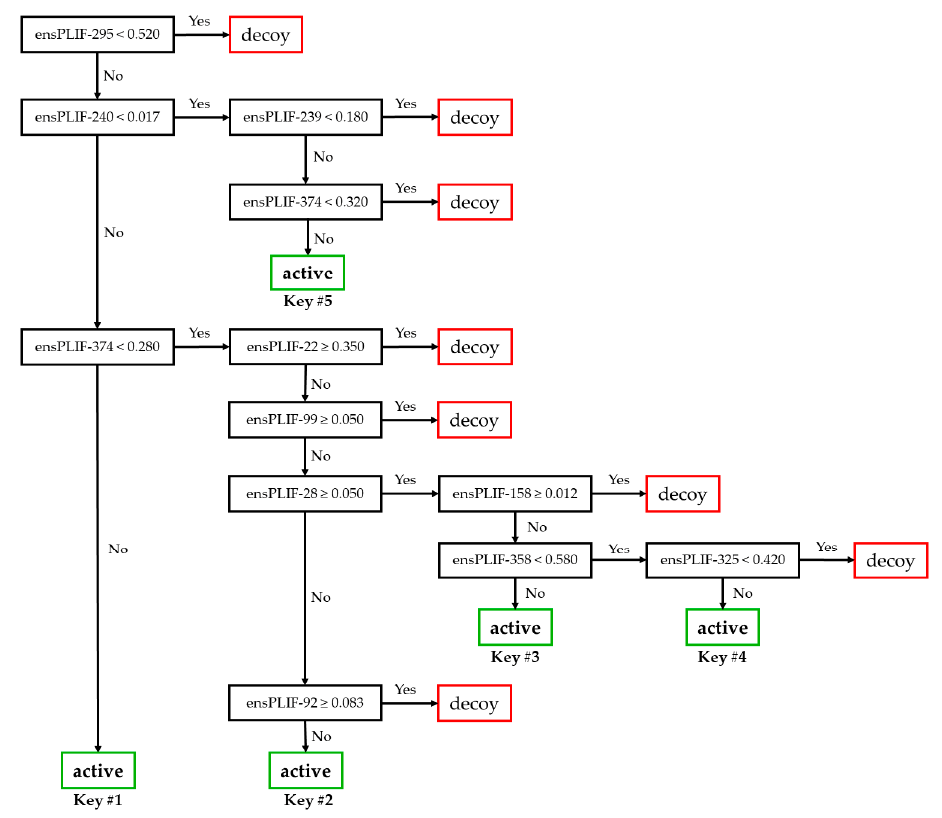
Figure 1. The decision tree resulted from the RPART run with the prior probabilities of 0.9:0.1.